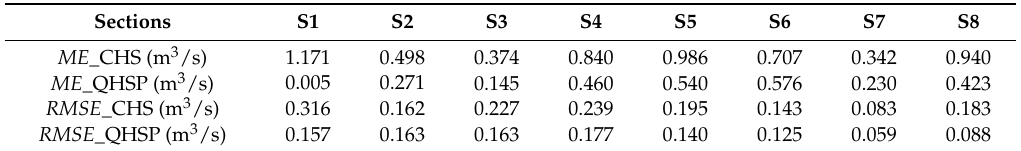
Figure 17. Comparison between the computed hydrographs at considered cross sections in Wangmaogou catchment. ( a ) Section S1; ( b ) Section S2; ( c ) Section S3; ( d ) Section S4; ( e ) Section S5; ( f ) Section S6; ( g ) Section S7; ( h ) Section S8. Table 5. Simulating errors of hydrographs at considered cross sections on the DEM constructed by using CHS and QHSP